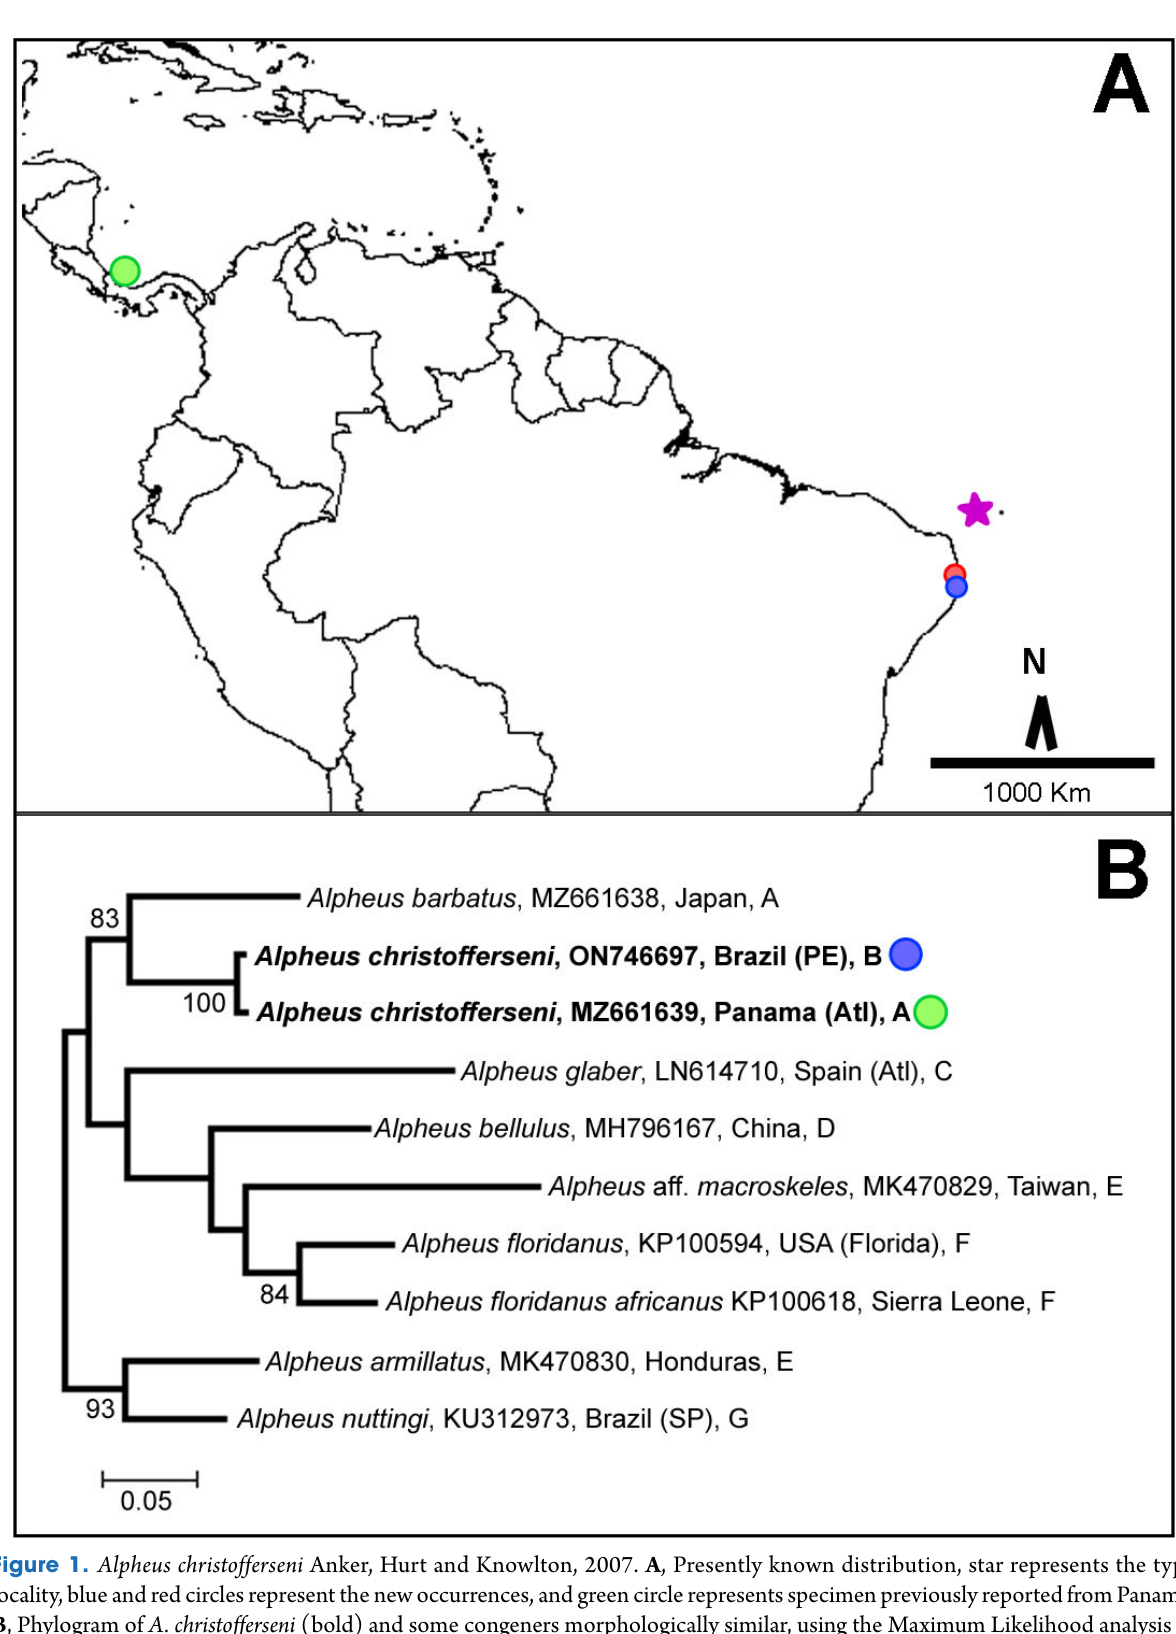
Figure 1. Alpheus christofferseni Anker, Hurt and Knowlton, 2007. A , Presently known distribution, star represents the type locality, blue and red circles represent the new occurrences, and green circle represents specimen previously reported from Panama. B , Phylogram of A. christofferseni (bold) and some congeners morphologically similar, using the Maximum Likelihood analysis of the 16S ribosomal subunit gene. Numbers are support values for 960 bootstraps; values < 75% were not included. Atl: Atlantic; PE: Pernambuco; SP: São Paulo. References: A, Chow et al. (2021); B, This study; C, Roura et al. (2018); D, Wang et al. (2020); E, Liao et al. (2019); F, Bracken-Grisson et al. (2014); G, Almeida et al.